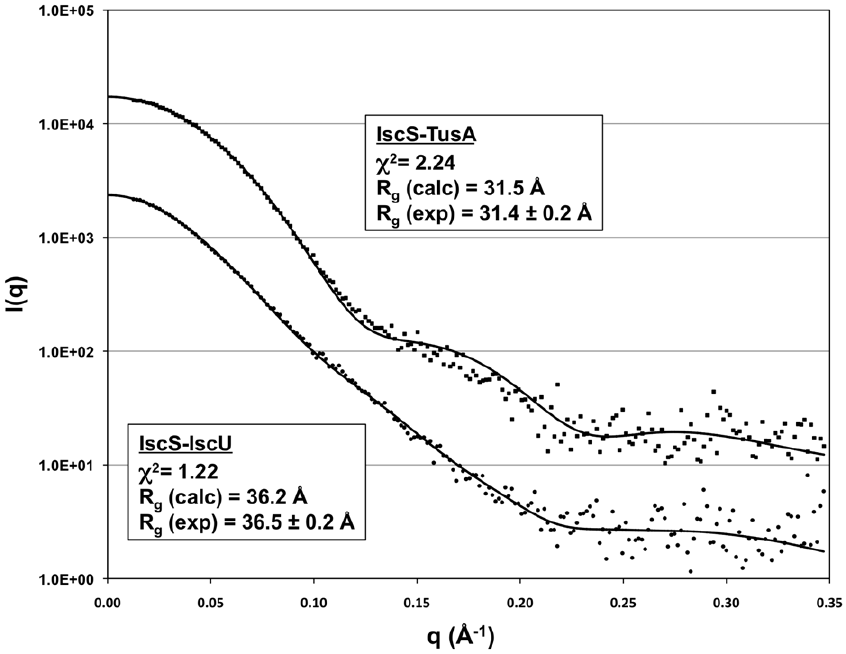
Figure 4. Small-angle X-ray scattering (SAXS) analysis of the complexes formed by IscS in solution. Scattering data (desmeared, merged, and binned) are shown as squares and circles for the IscS-TusA and IscS-IscU complexes, respectively. The predicted scattering profiles calculated in CRYSOL from atomic coordinates are shown as plain black lines. The profiles were offset on the vertical axis for clarity. doi:10.1371/journal.pbio.1000354.g004 PLoS Biology |